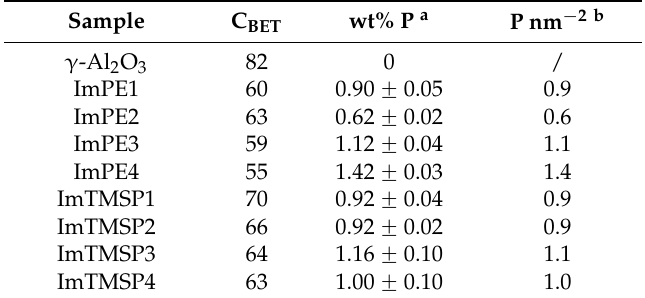
Table 2. Characteristics of the γ -alumina powders before and after grafting reactions.